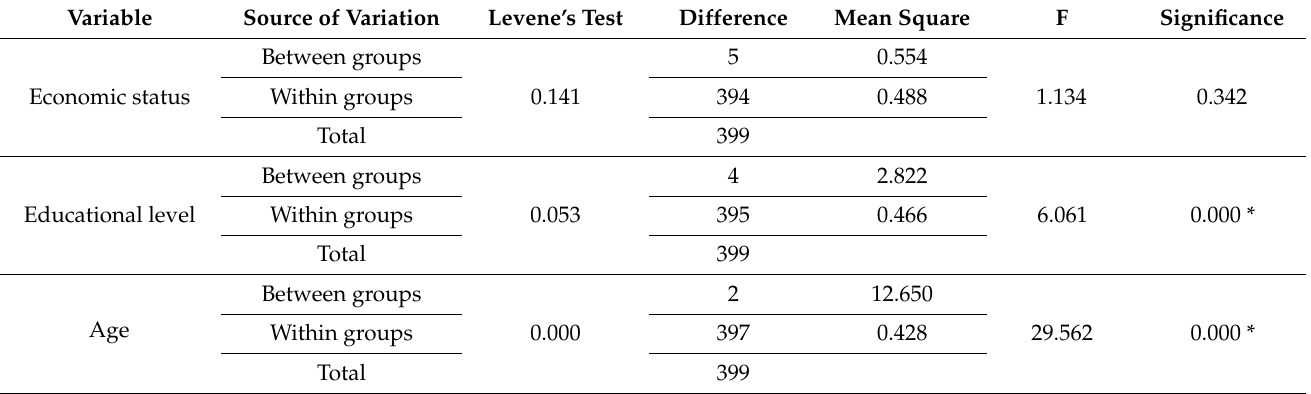
Table 4. Comparison of the mean GSEOH scores among different age groups, educational levels, and economic status using the one-way ANOVA